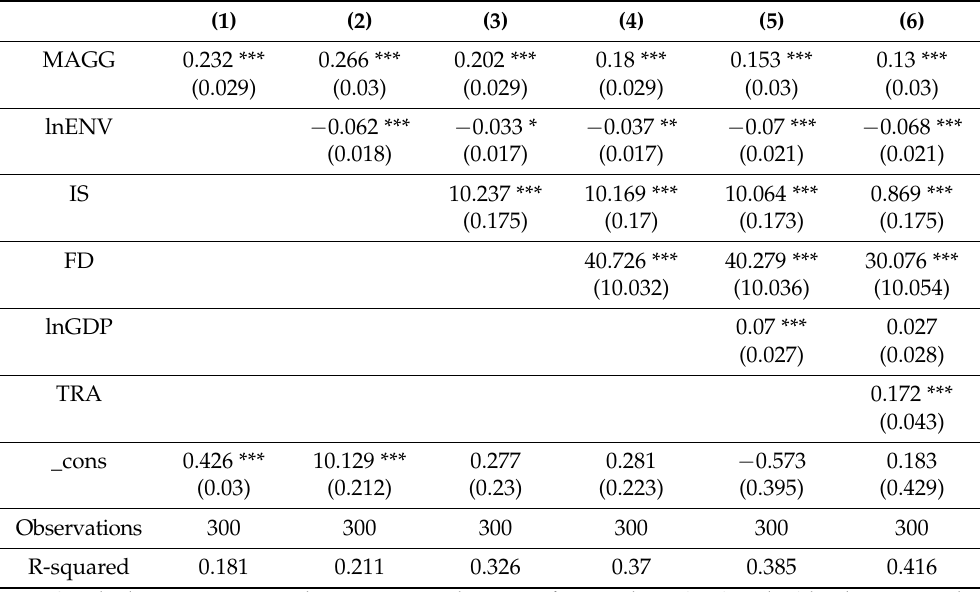
Table 4. Stepwise regression